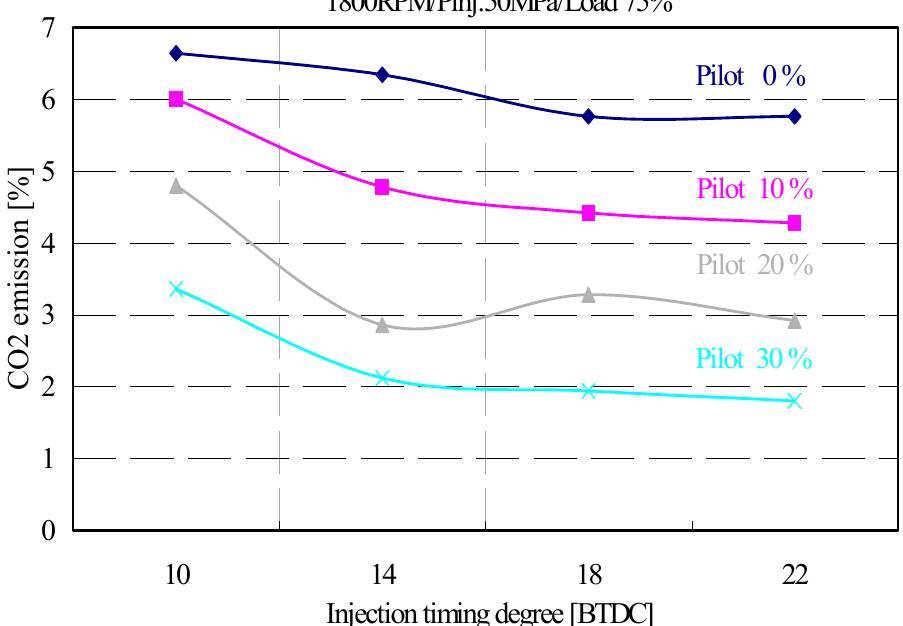
Figure 14. CO 2 emission characteristics of DME engines with the pilot injection duration rate as a function of injection timing.